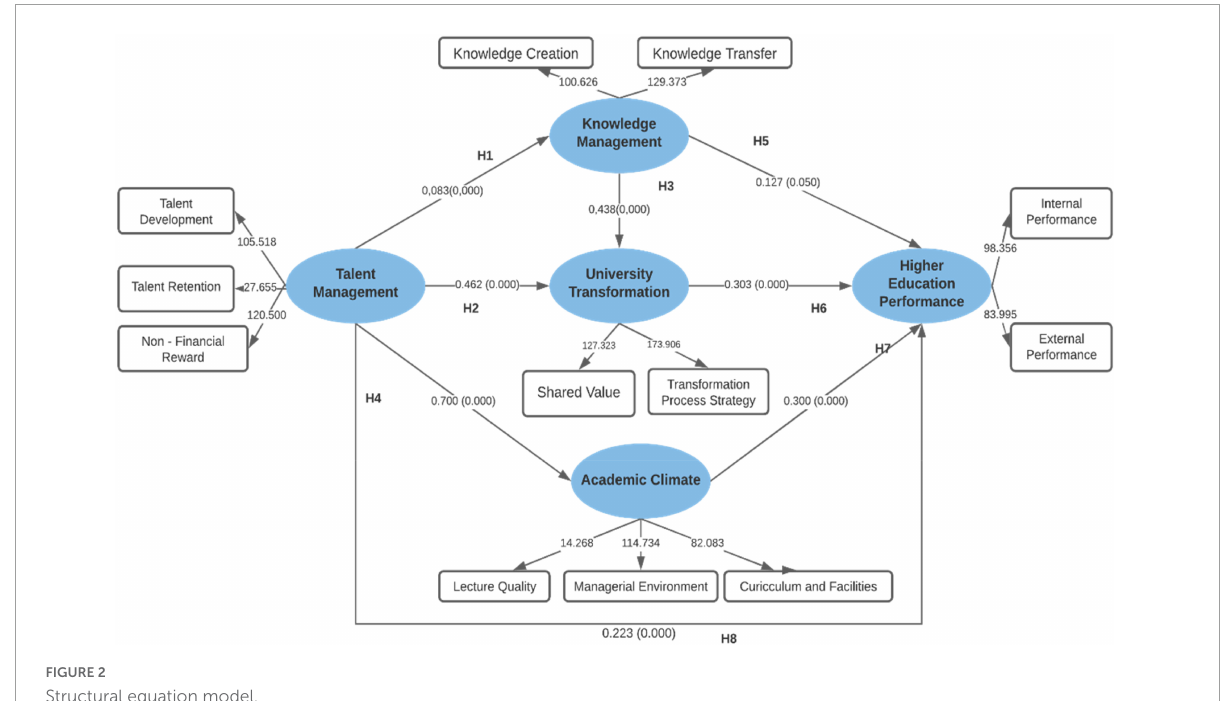
FIGURE2 Structural equation model.